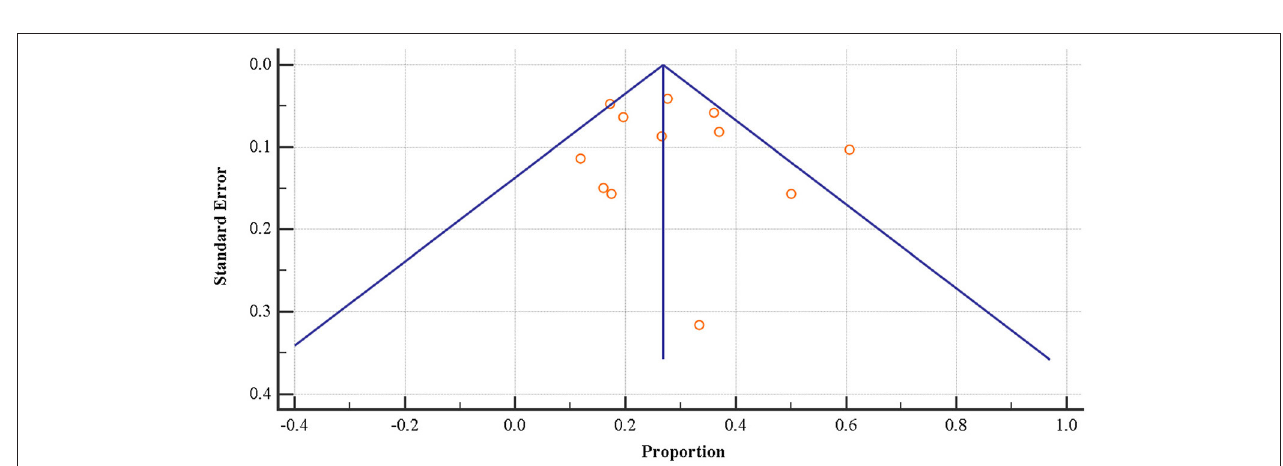
FIGURE 1 | Forest plot of the prevalence rate of emotional exhaustion among physical education teachers.